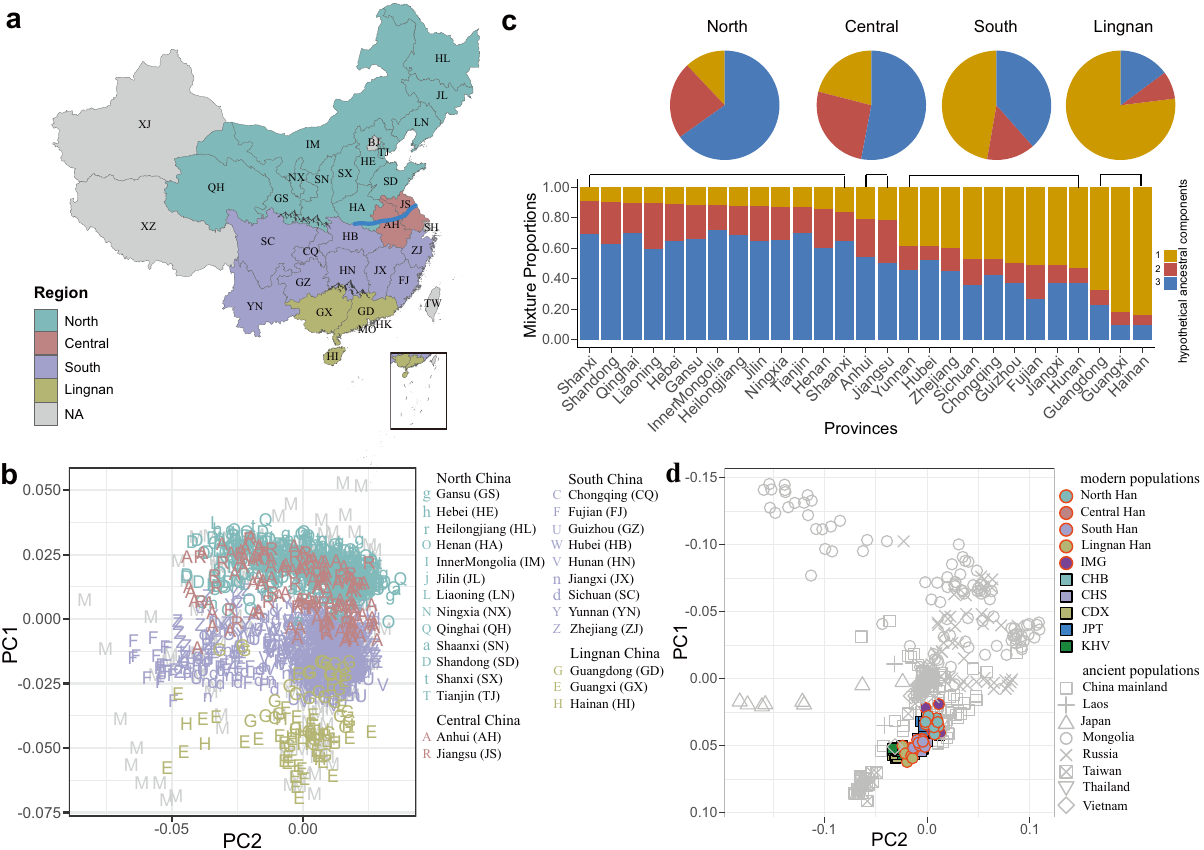
Fig. 4 PCA and ADMIXTURE analysis of the Han Chinese populations and East Asians. a A map of the People ’ s Republic of China showing its 34 administrative divisions. “ NA ” indicates that the Han Chinese samples were not recruited from that region. The Qinling-Huaihe River line lies in central China, while the Nanling Mountains are in southern China. b Principal component analysis (PCA) of the Han and Minority Chinese individuals from four sub-regions. The administrative divisions are shown by the distinct letters. Minority individuals are marked with “ M ” . The Han Chinese populations can be classi fi ed into four subgroups: North Han (cyan color), Central Han (dark-red color), South Han (purple color), and Lingnan Han (golden color). c ADMIXTURE analysis of 2056 Han Chinese individuals from 27 administrative divisions for the optimal K value = 3. Each vertical bar represents the average proportion of ancestral components in the regions. The length of each color indicates the percentage of inferred ancestry components from ancestral populations. The upper pie charts denote the average proportion of components across individuals from the four subgroups. d Plots of the fi rst two principal components for modern and ancient East Asian individuals. Source data are provided as a Source Data fi